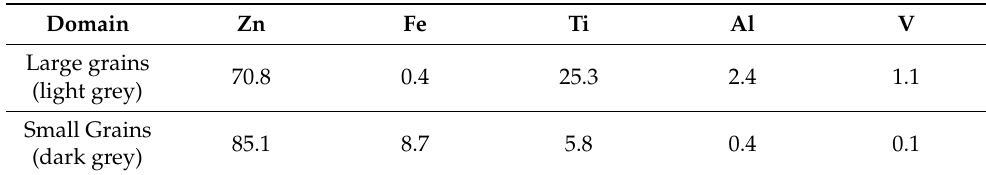
atoms, which share the same column in the periodic table, to create TiFe 2 Zn 20 with a ≈